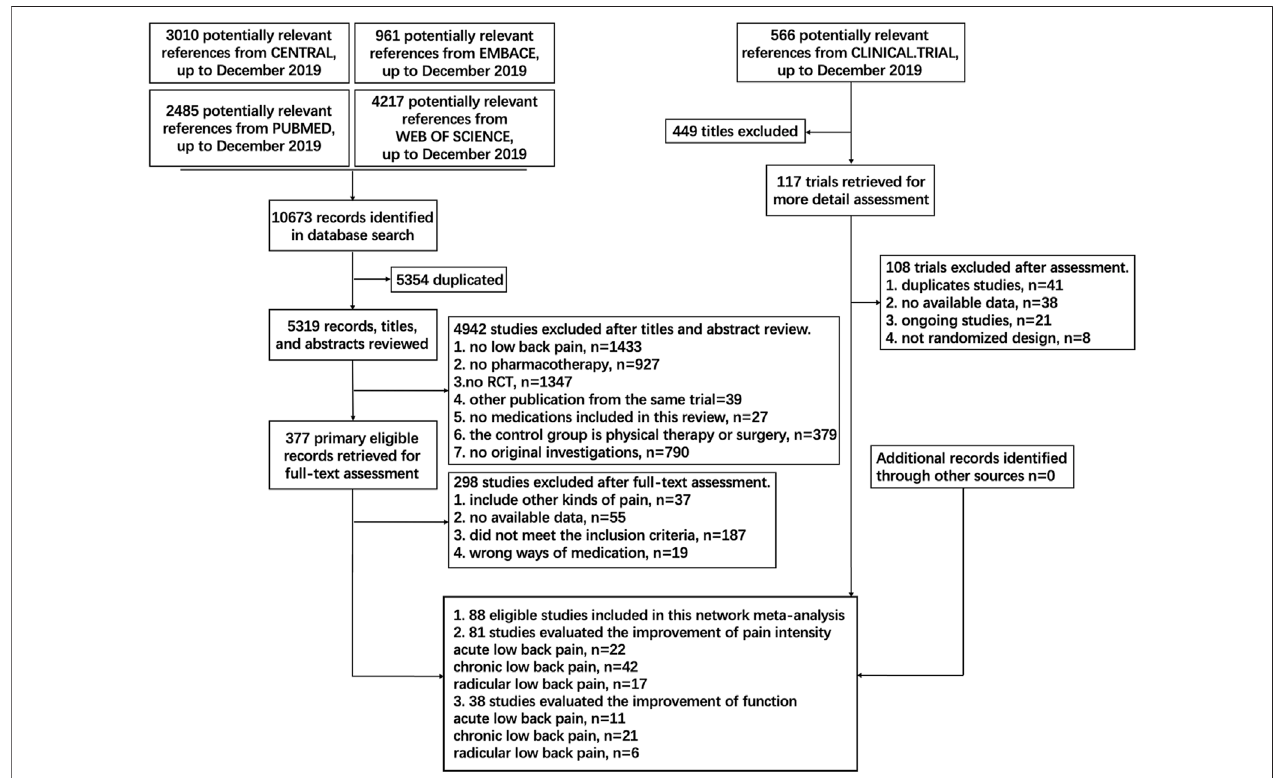
FIGURE1| Abbreviations:PLA,Placebo;OPI,Opioids;NSA,Non-steroidalanti-in fl ammatorydrug;TCA,Tricyclicantidepressant;TAP,Tapentadol;SSI,Selective serotonin reuptake inhibitor;GMA,GABAmimetic antiepileptics (Pregabalin or Gabapentin); ANE, Antiepileptic (apartfromPregabalinand Gabapentin); TRA, Tramadol; DUL, Duloxetine; C-NSA, Cyclo-oxygenase 2-selective non-steroidal anti-in fl ammatory drugs; ACE, Acetaminophen; TAN, Tanezumab; COR, Corticosteroids; DIA, Diazepam; SMR, Skeletal muscle relaxants; ANC, Anticholinergics (Diphenhydramine or Benztropine); ALG, Acetylsalicylic acid + Acetaminophen + Caffeine + Chlorpheniramine; BUP, Buprenorphine. Details of the electronic search and study selection fl ow diagram.